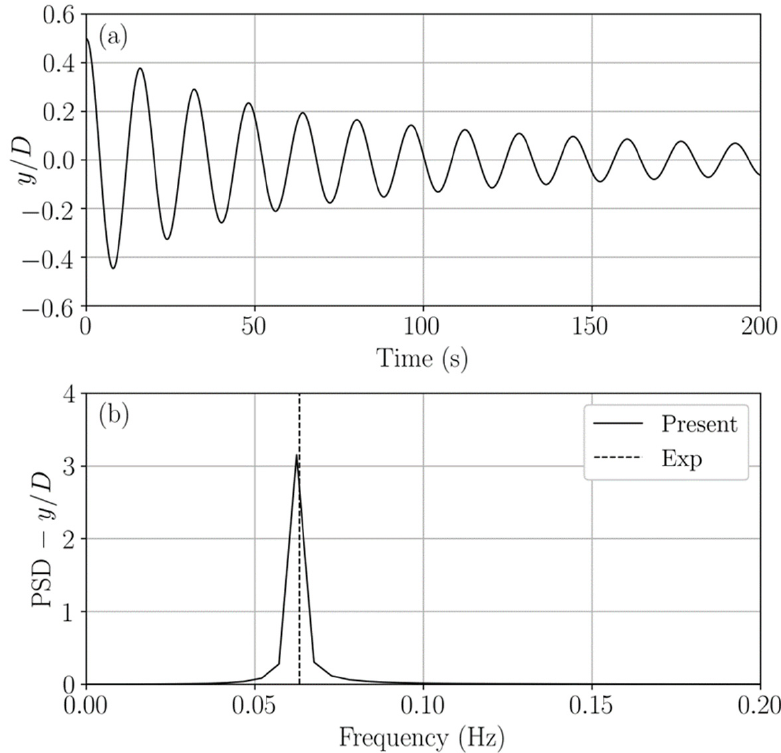
Figure 8. Free decay test of FOWT platform in transverse direction: ( a ) time series; ( b ) PSD.